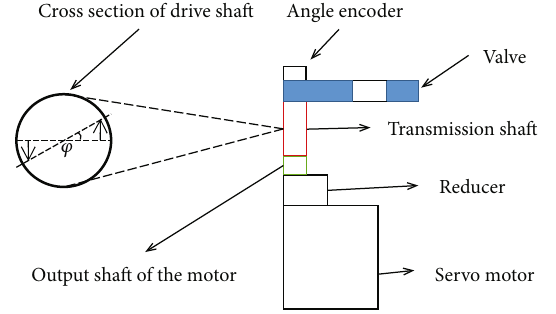
Figure 13: Deformation of the valve connecting shaft.